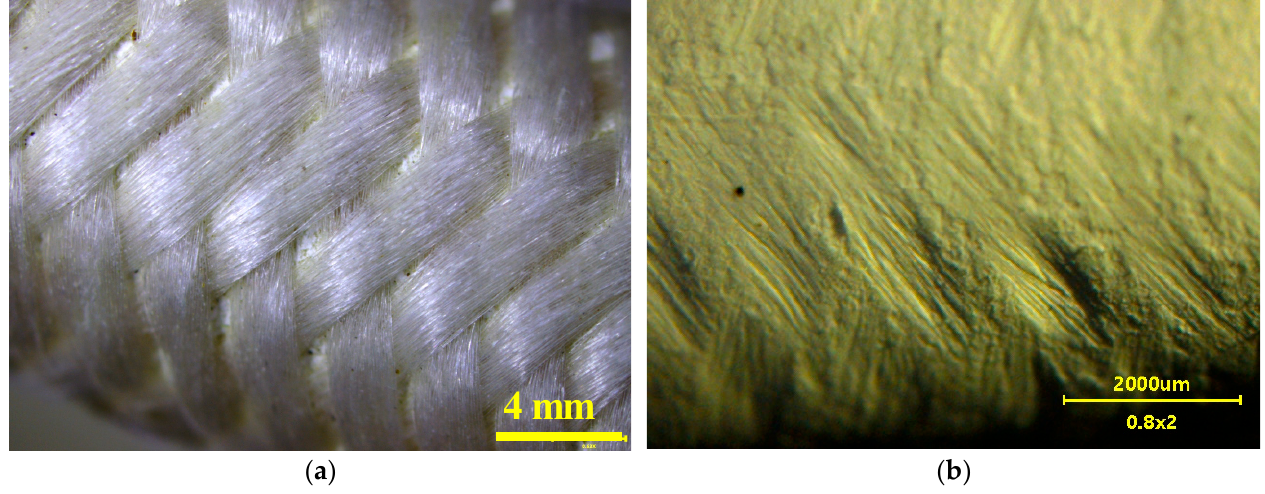
Figure 2. Membrane Accurel PP V8/2 with assembled net. ( a ) membrane surface covered by net, ( b ) membrane surface after removing the net.